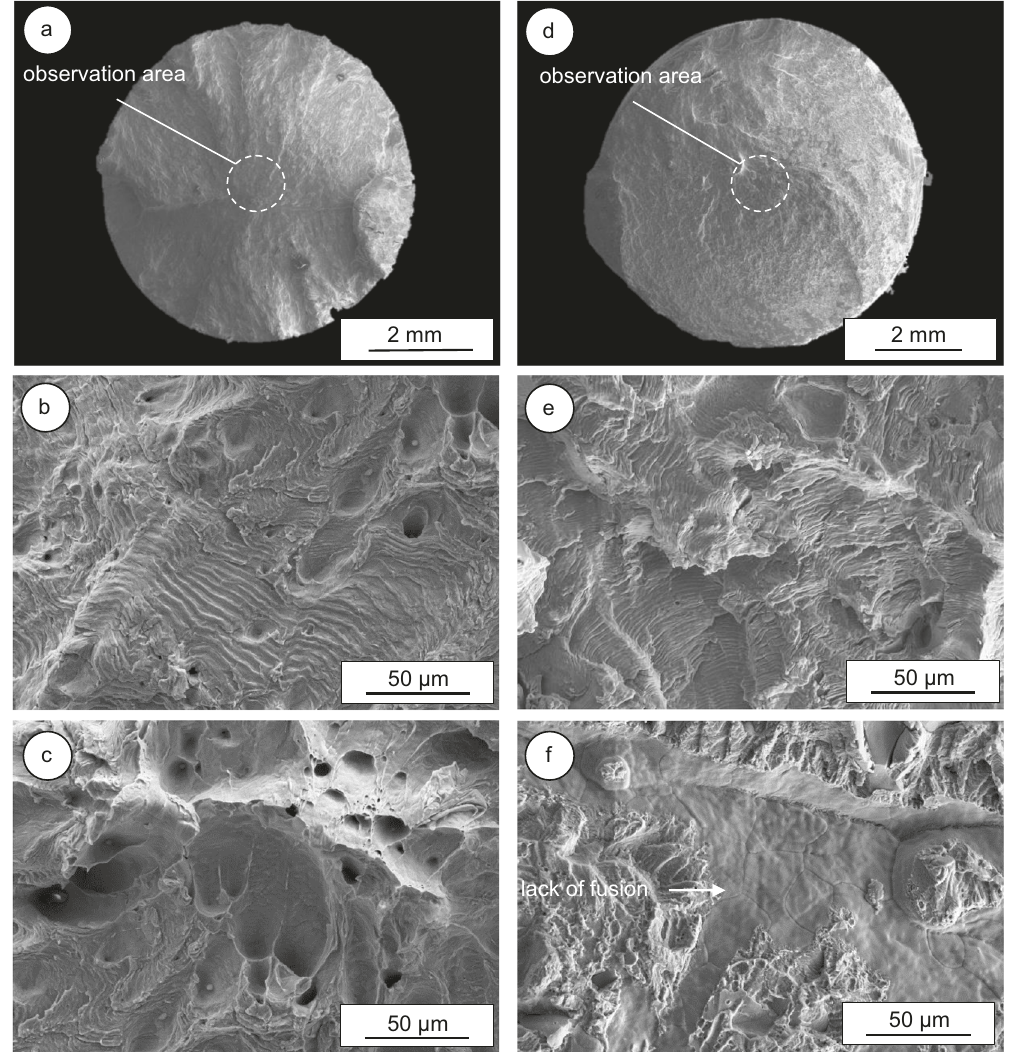
Fig. 5 Representative images of the fracture surface using secondary electron contrast mode. a Fatigued HR iron specimen (250 MPa, 9.1 × 10 5 cycles) with an overview of the entire fracture area b striations and c areas of ductile fracture; fatigued EBM iron specimen (250 MPa, 1 × 10 5 cycles) with d overview of the entire fracture area e striations and f areas with LOF.